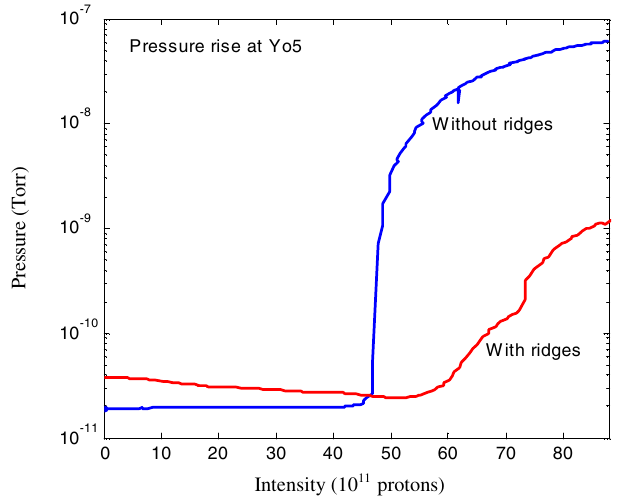
FIG. 7. (Color) The pressure rise at Yo5 is shown against the beam intensity for 2004, without ridges, and 2005, with ridges. Both beam injections are in the 110-bunch mode and bunch intensity of 1 : 5 (cid:3) 10 11 protons. The vacuum and other condi- tions at Yo5 are not changed from 2004 to 2005, except for the installation of ridges. The early part of the pressure rise of 2005, with ridges, is a little higher than the one of 2004, which is the remnant of the previous beam injections induced pressure rise.